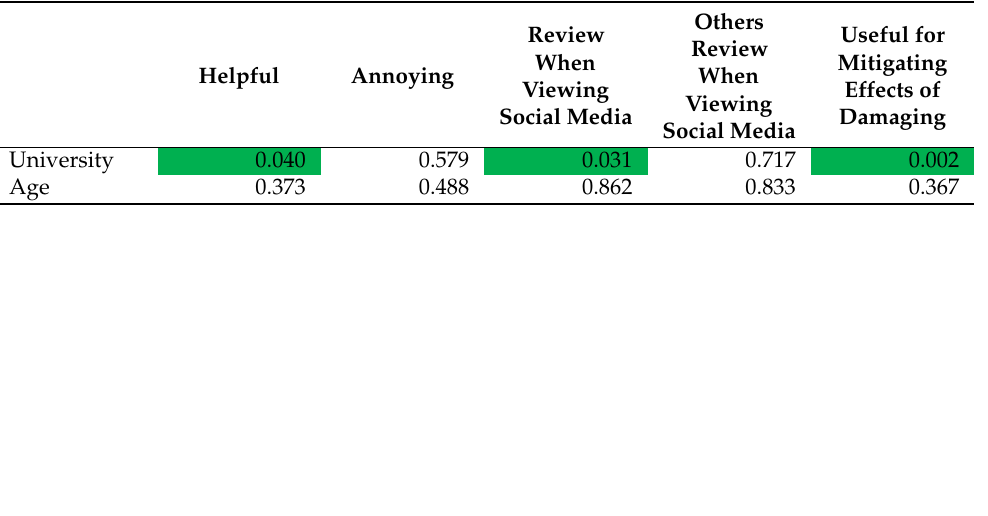
Table A7. Statistical significance calculations for both age and university comparison